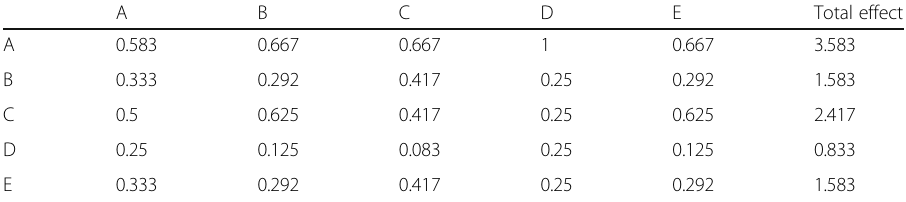
Table 3 Total effect of one node on another up to 2 steps for the toy network shown in Fig. 1. Each cell records the total effect from one node in a particular row on another node in a particular column. The last column records the total effect each node has on the whole network A B C D E Total effect 0.583